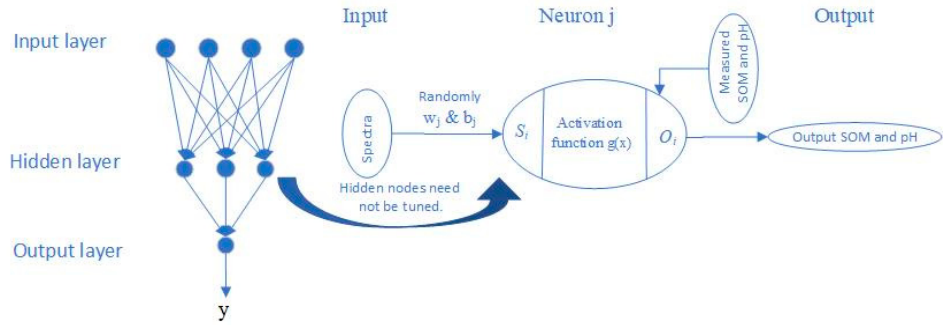
Figure 2. Structure of ELM ( w j , weighting; b j , biases).